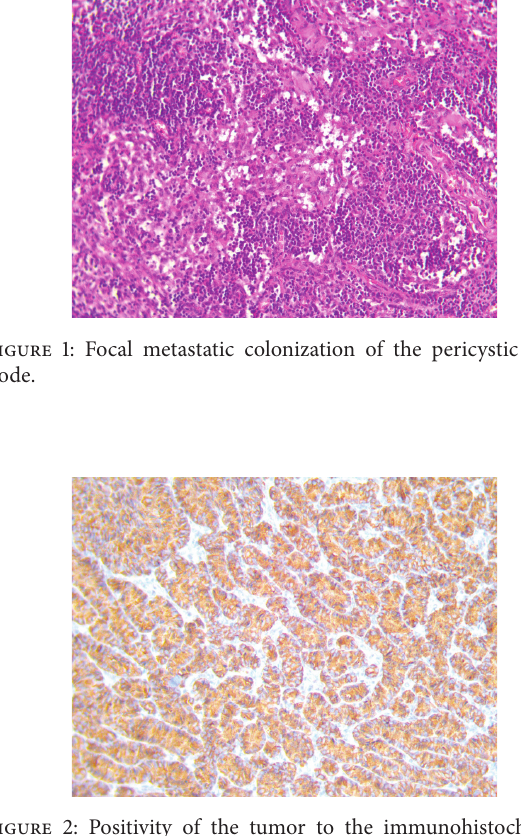
Figure 2: Positivity of the tumor to the immunohistochemical staining for